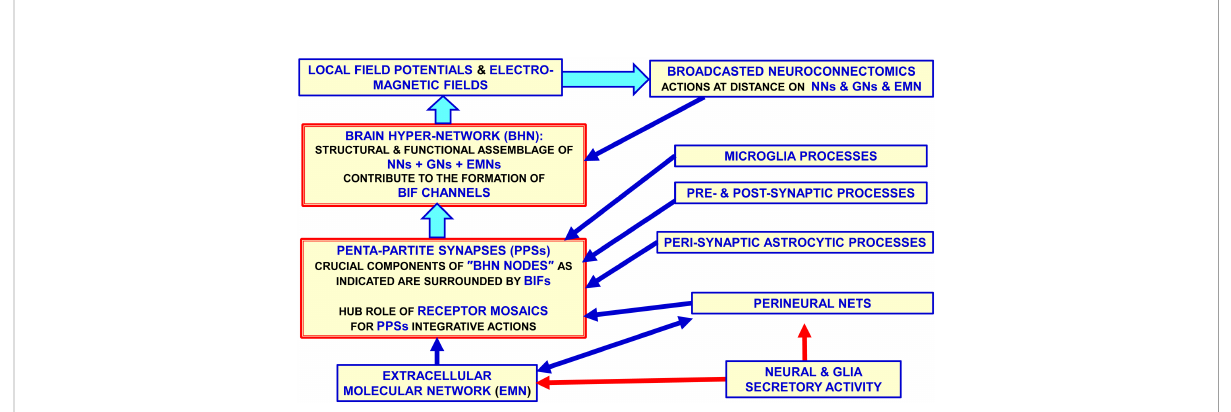
FIGURE 3 Glial cells, extracellular matrix and neurons build up penta-partite synapses (PPSs): penta-partite synapses are crucial components of the Brain Hyper-Network (BHN) nodes and are surrounded by Brain Interstitial Fluid (BIF) channels that allow a control of signals exchange between the synapse and the extra-cellular fl uid. It should be noted that some highly pervasive signals as the electromagnetic fi eld do not need the BIF channels to reach the PPS components. While neurons, astrocytes and extracellular matrix are structural components of the synapse, microglia can be mainly involved in transient functional regulating roles at the synapse in normal brain homeostasis and in disease. Modi fi ed from (2). BHN, Brain Hyper-Network; BIF, Brain Interstitial; Fluid, GNs glial networks; NNs, neural networks.